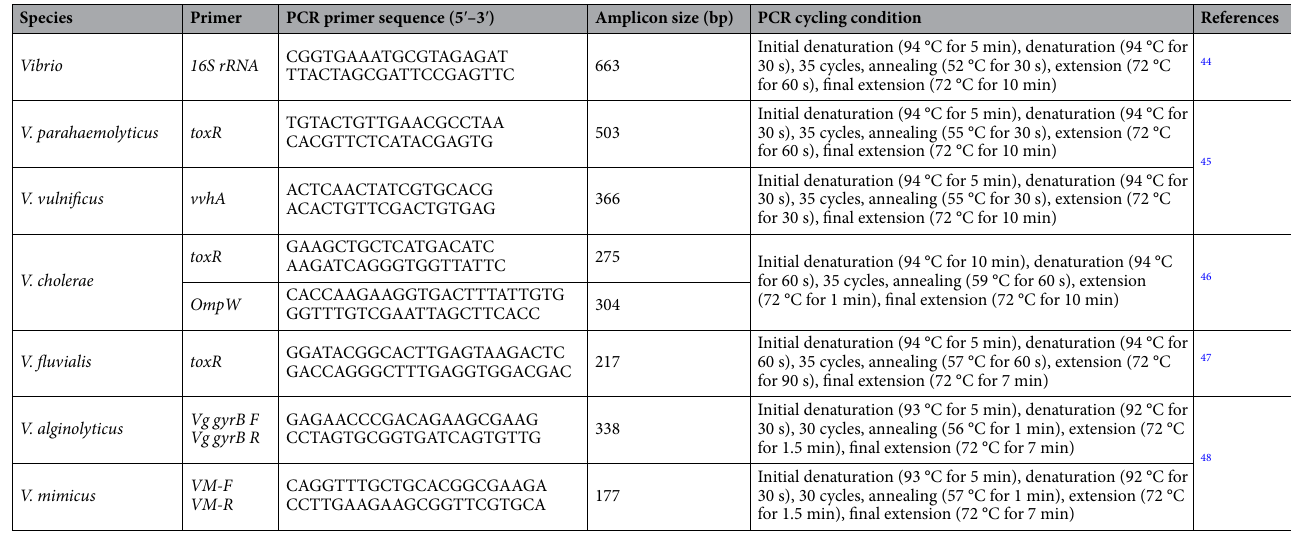
Table 1. PCR condition and primer sets used for the screening of Vibrio spp.